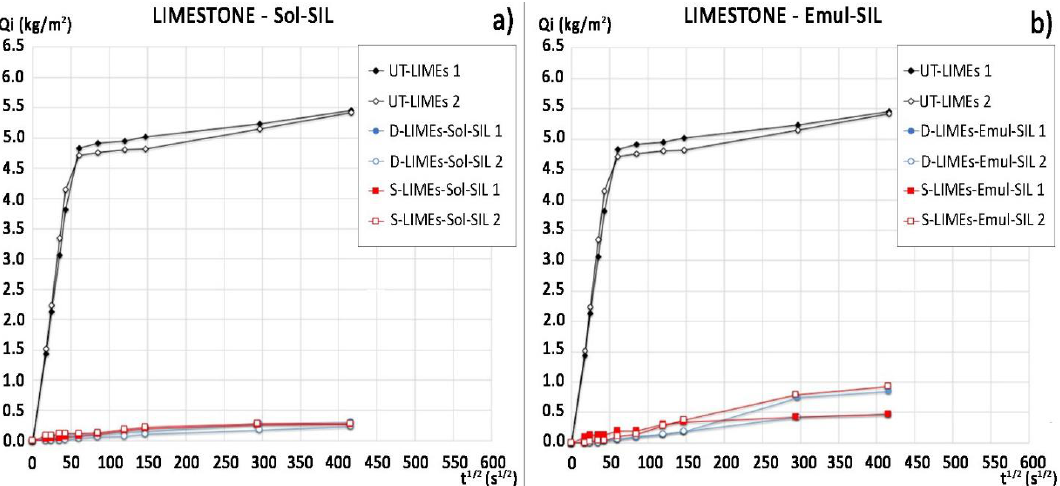
Figure 6. Water absorption curves of limestone samples treated with: ( a ) Sol-SIL by dip coating and spray and of untreated samples (replicate samples for each condition); ( b ) Emul-SIL by dip coating and spray and of untreated samples (replicate samples for each condition).